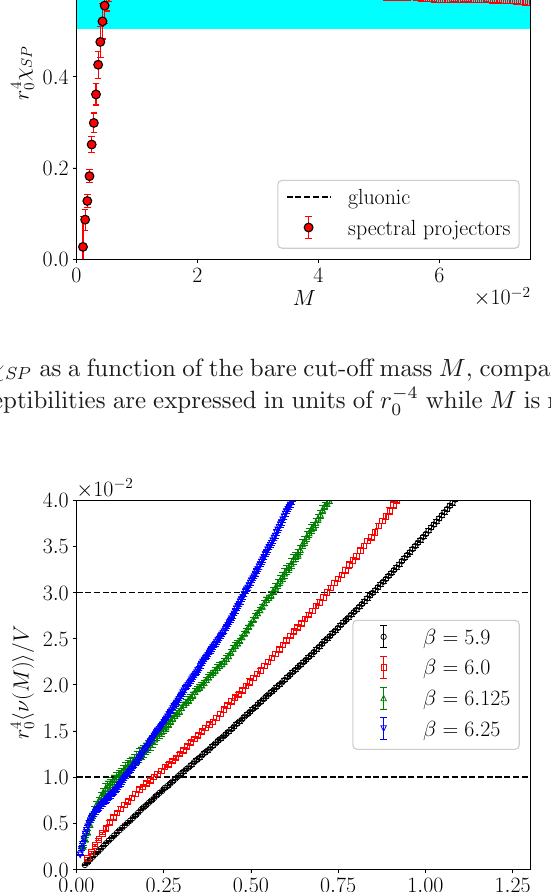
Figure 2 . Behavior of h ν ( M ) i /V as a function of the bare cut-off mass M for 4 different values of the lattice spacing. The mean number of modes is expressed in units of r − 4